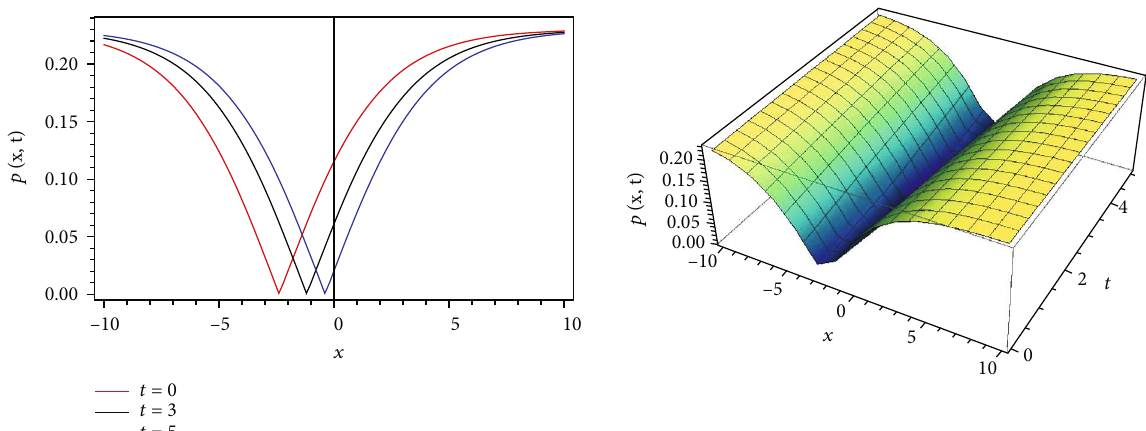
: 1, β : 1, γ : 1, k = 0 : 6, A = 0 : 1, m = 0 : 01, d = 0 : 5, ρ = 0 : 4, δ = j = 0 j = 0 j = 0 0